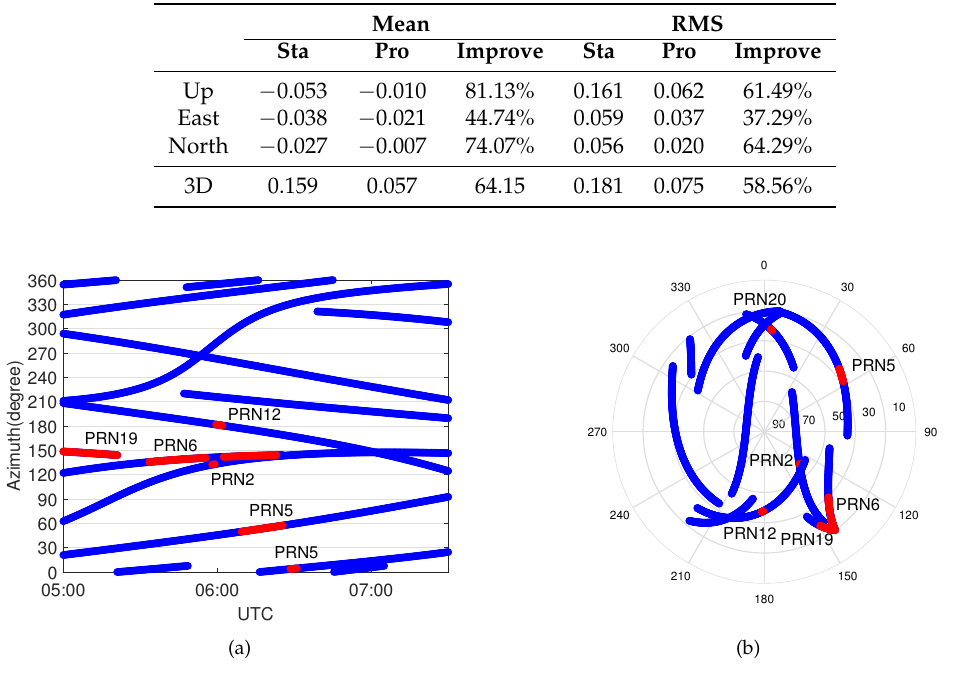
Figure 7. Occurrences of model errors (indicated in red) during Event 1 as function of ( a ) time and azimuth and ( b ) elevation and azimuth (skyplot). The blue lines represent the trajectories of the satellites, and the red points indicate that model errors are identified at those